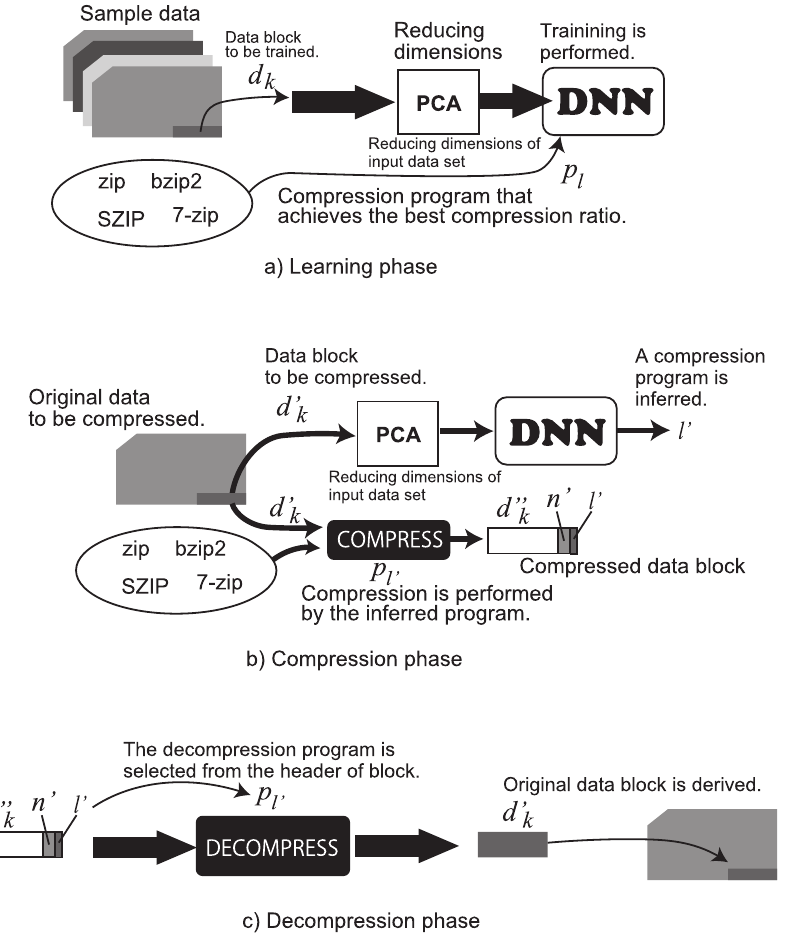
Figure 1. The block diagram of the proposed